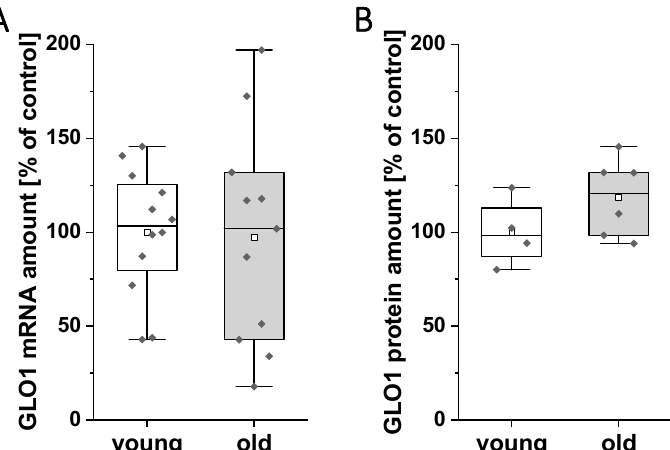
Figure 5. Quantification of GLO1 mRNA and protein amount in 6-day old blastocysts from young and old rabbits. ( A ) GLO1 mRNA levels were quantified by qPCR. ( N = 2, n ≥ 11) ( B ) For GLO1 protein analysis by the Simple Western method pooled embryonic samples with 5–13 blastocysts were used ( N = 2, n ≥ 4). Results are shown as box plots. Relative mRNA and protein amount are normalised to the levels of vinculin. All values are expressed in per cent, with young = 100%.